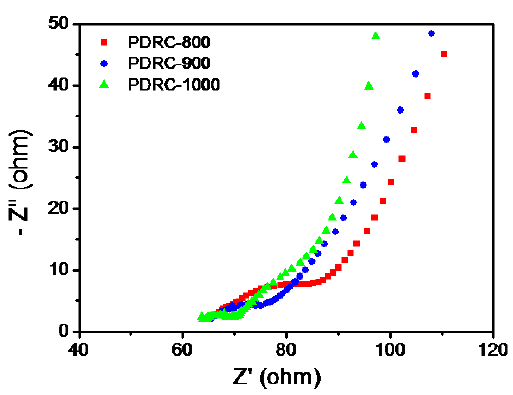
Figure 6. Electrochemical impedance spectroscopy (EIS) Nyquist plots of PDRC-800, PDRC-900 and PDRC-1000.